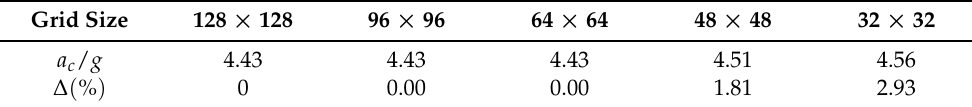
Table A4. Spacial grid size sensibility analysis of a c / g for VOF S in the linear regime. Grid Size